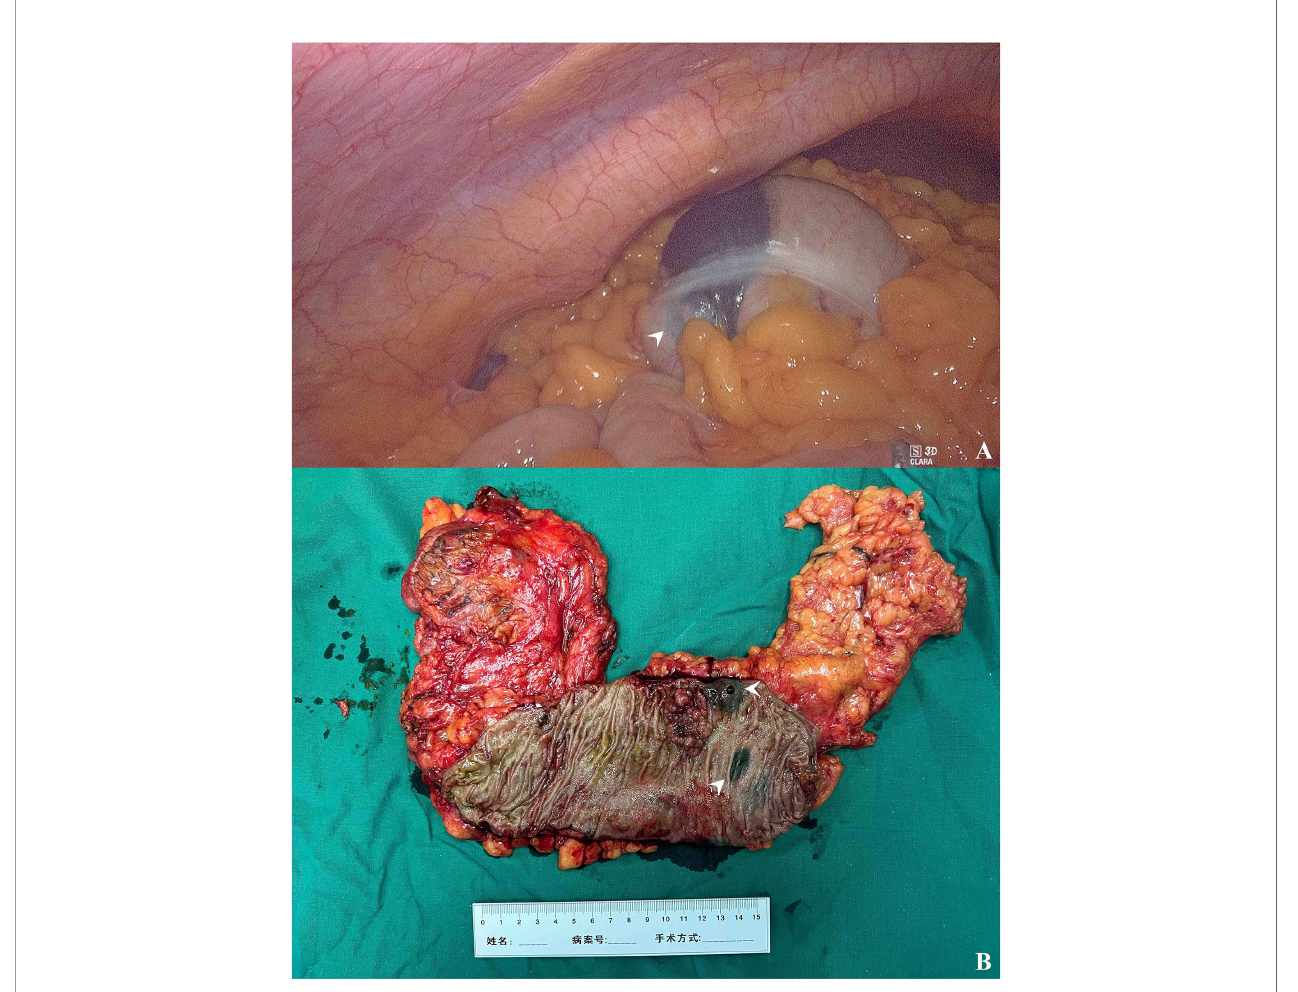
FIGURE 4 | The intraoperative fi nding of tattooed colon cancer. (A) The black patch in the hepatic fl exure under laparoscopy (arrowhead). (B) The resected surgical specimen and two tattoos caudally to the cancer lesion